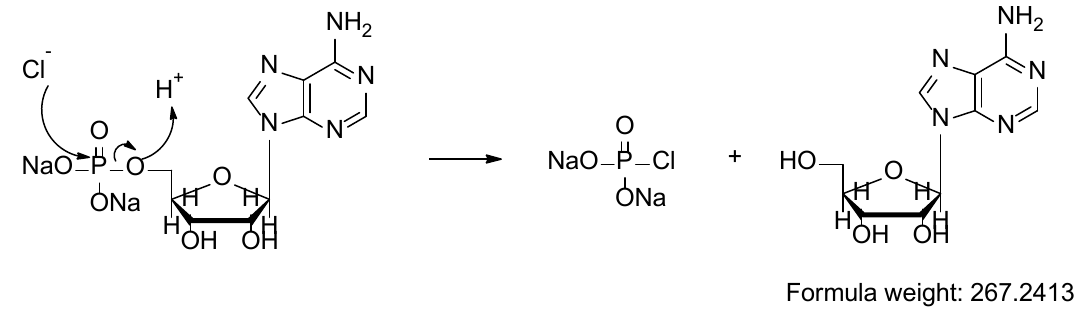
Scheme 2: Proposed mechanism of acidic hydrolysis of AMPNa